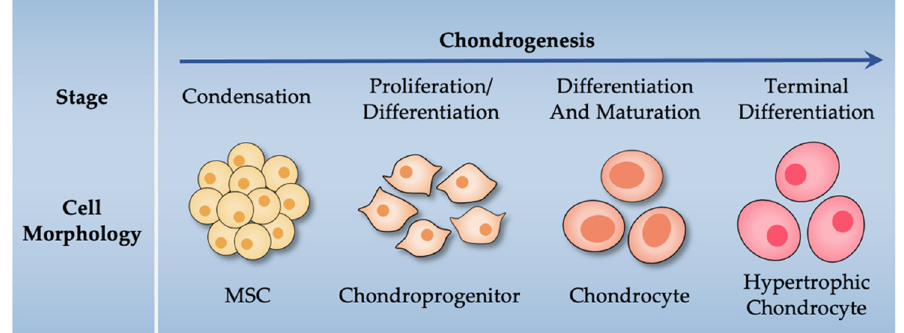
Figure 2. Key stages of chondrogenic differentiation of